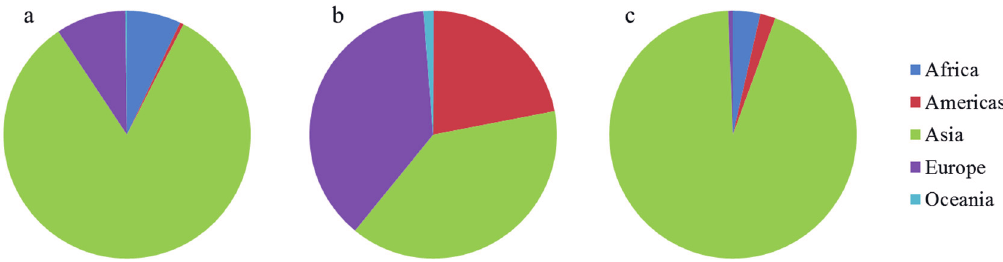
Figure 3. Main aquaculture regions of fish species in 2013: ( a ) marine fish species; ( b ) diadromous fish species; and ( c ) freshwater fish species.